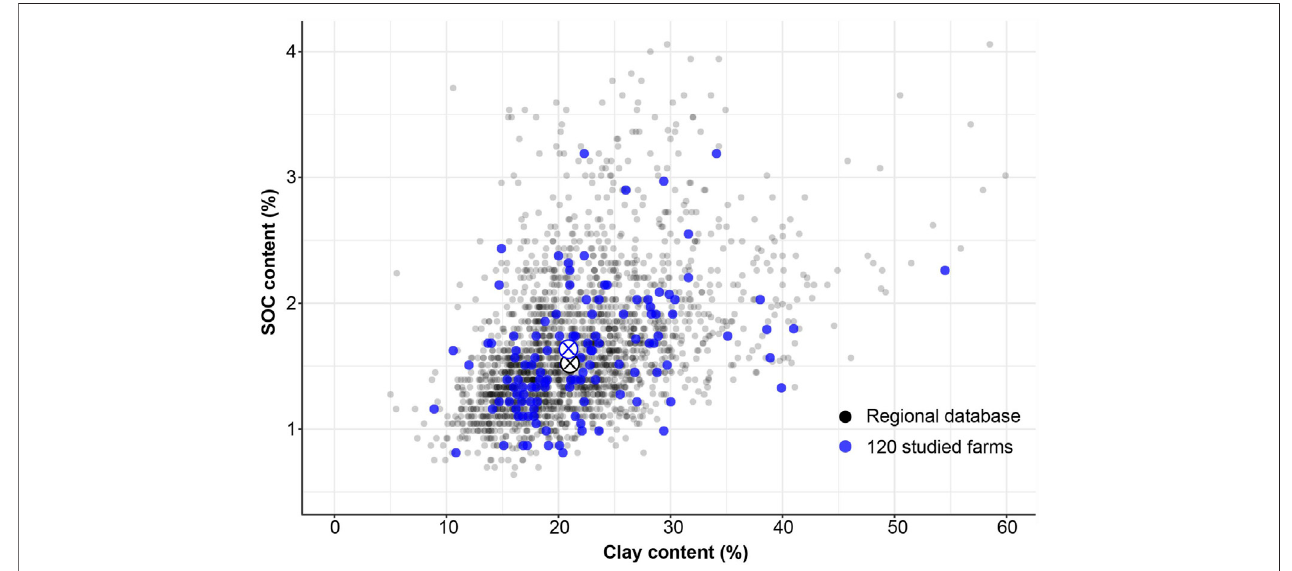
FIGURE 2 | SOC vs. clay contents (circles) and respective centroids (circled X) of soil samples from the regional Geneva and Vaud database (grey) and from sampled fi elds of the 120 surveyed farms (blue).